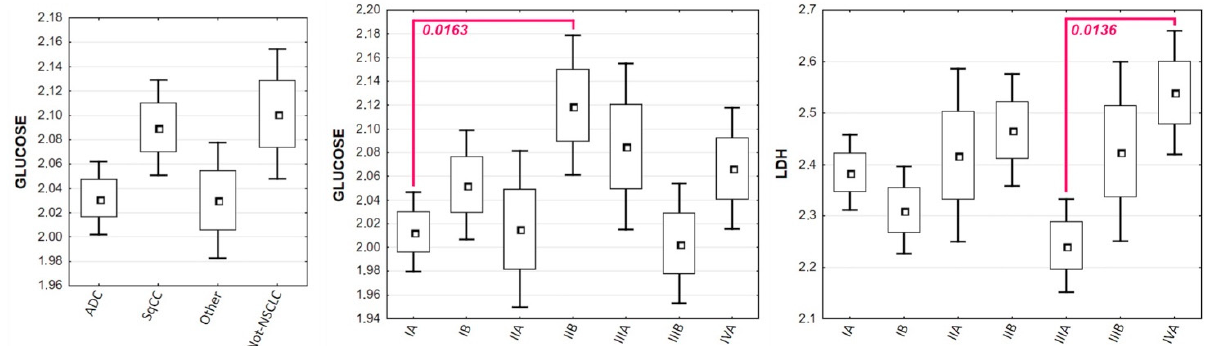
Figure 4. Distribution of glucose levels in lung cancer subtypes and stages, with a statistically significant difference between patients with stage IA and stage IIB lung cancer ( p = 0.0163), and the activity of LDH between lung cancer stages, with a statistically significant difference between patients with stage IIIA and stage IVA lung cancer ( p = 0.0136). Table 5. The pairwise correlation of tumor, inflammatory, and metabolic marker combinations among the lung cancer groups studied. Marker’s